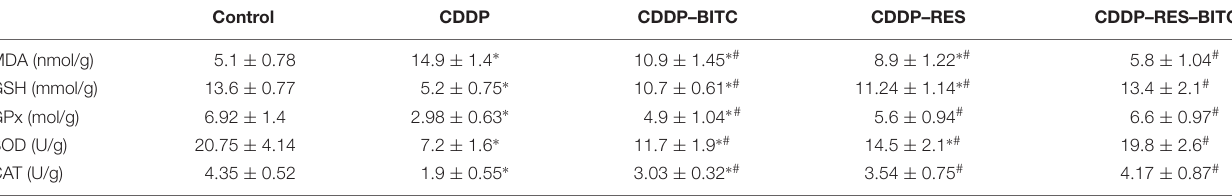
TABLE 1 | The effects of RES and BITC treatment on renal tissue lipid peroxidation GSH concentration and activities of antioxidantenzymes in cisplatin-intoxicated